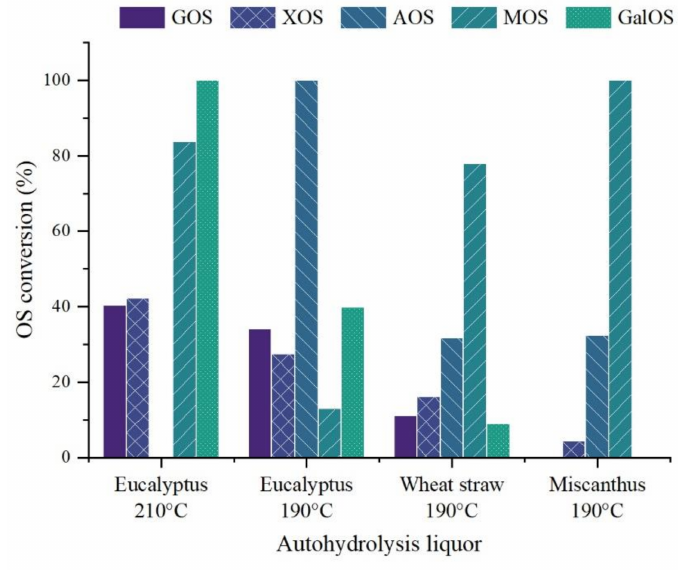
Figure 6. Conversion of oligosaccharides during catalytic hydrolysis of liquors.